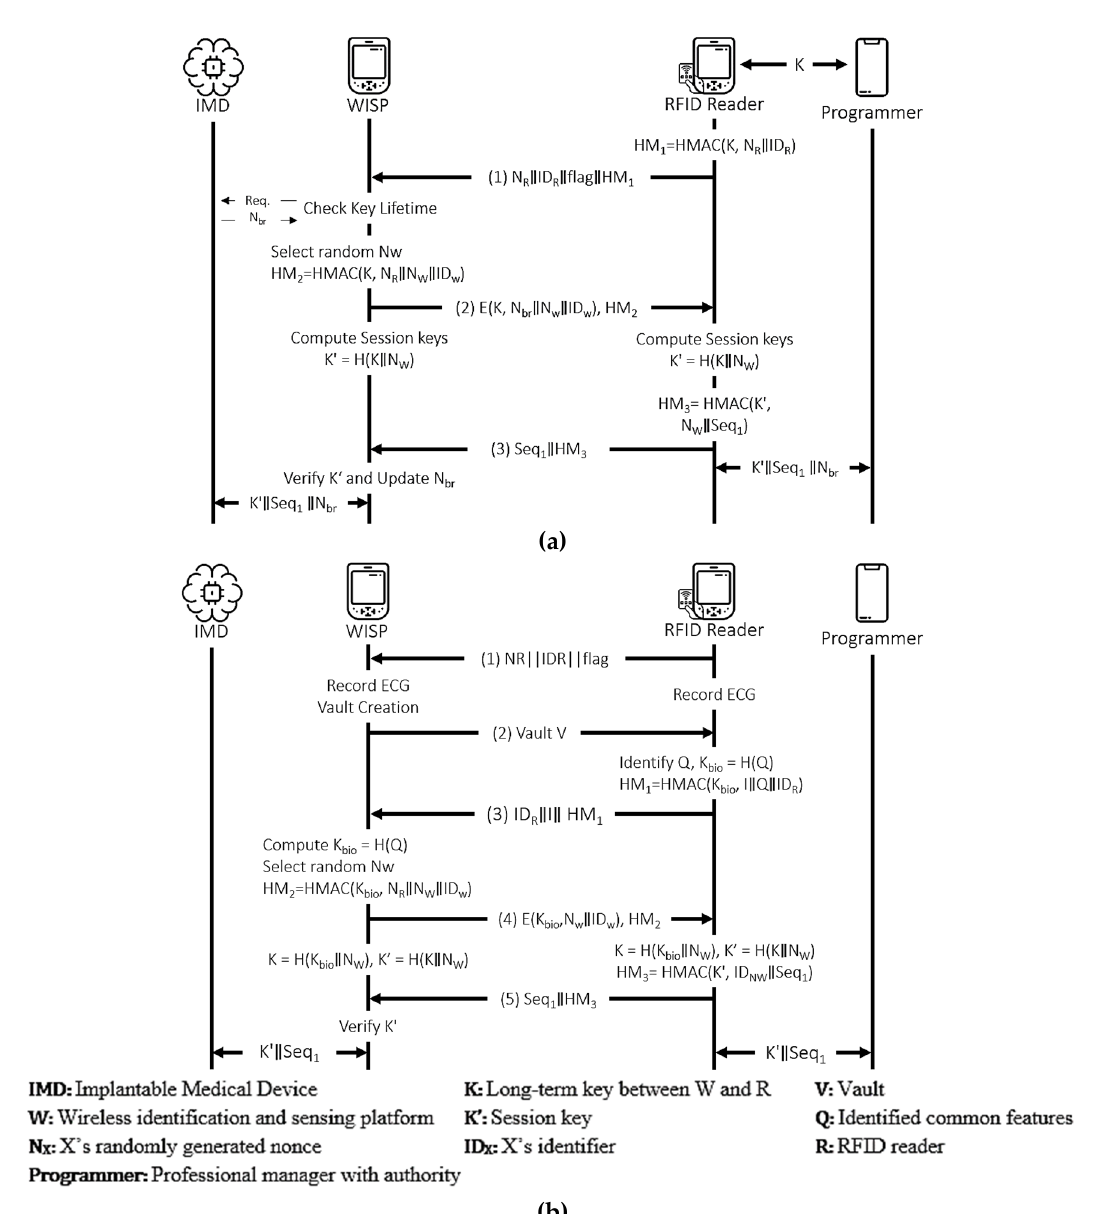
Figure 16. Ellouze et al.’s protocol. ( a ) Regular Mode. ( b ) Emergency Mode.